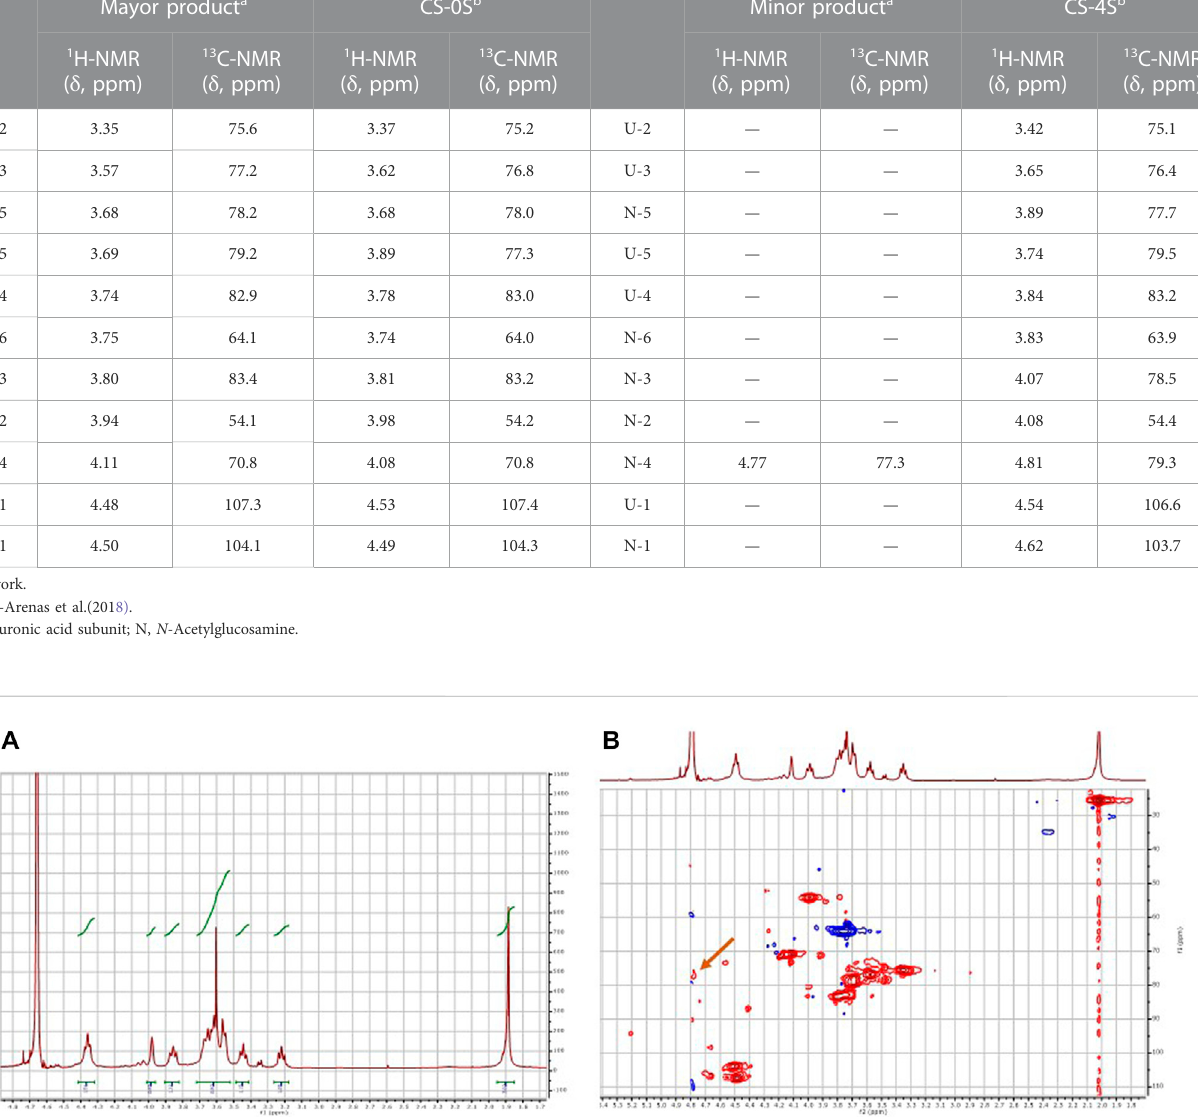
TABLE 1 Comparison of the chemical shifts of the obtained reaction product and those of the previously described CS-0S (Benito-Arenas et al., 2018). Mayor product a